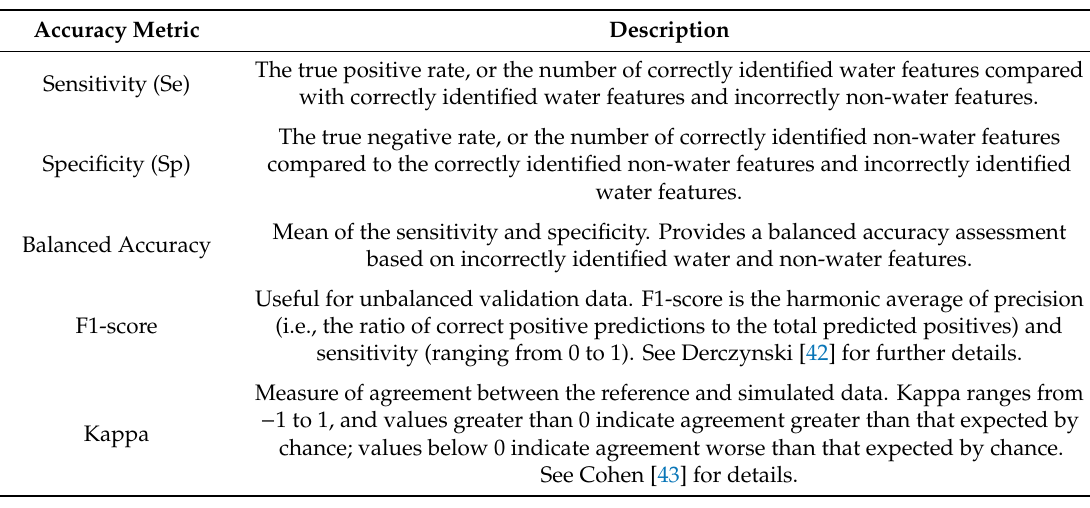
Table 1. Summary of metrics used to assess the accuracies of the water masks derived using the automated threshold selection